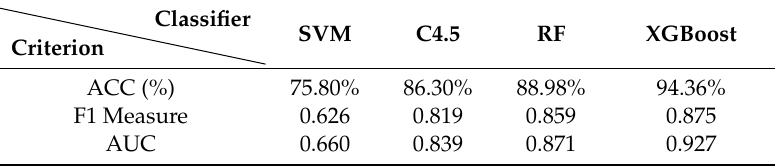
Table 6. Prediction performance (accuracy, F1 measure, and AUC ) of each classifier using their optimal features